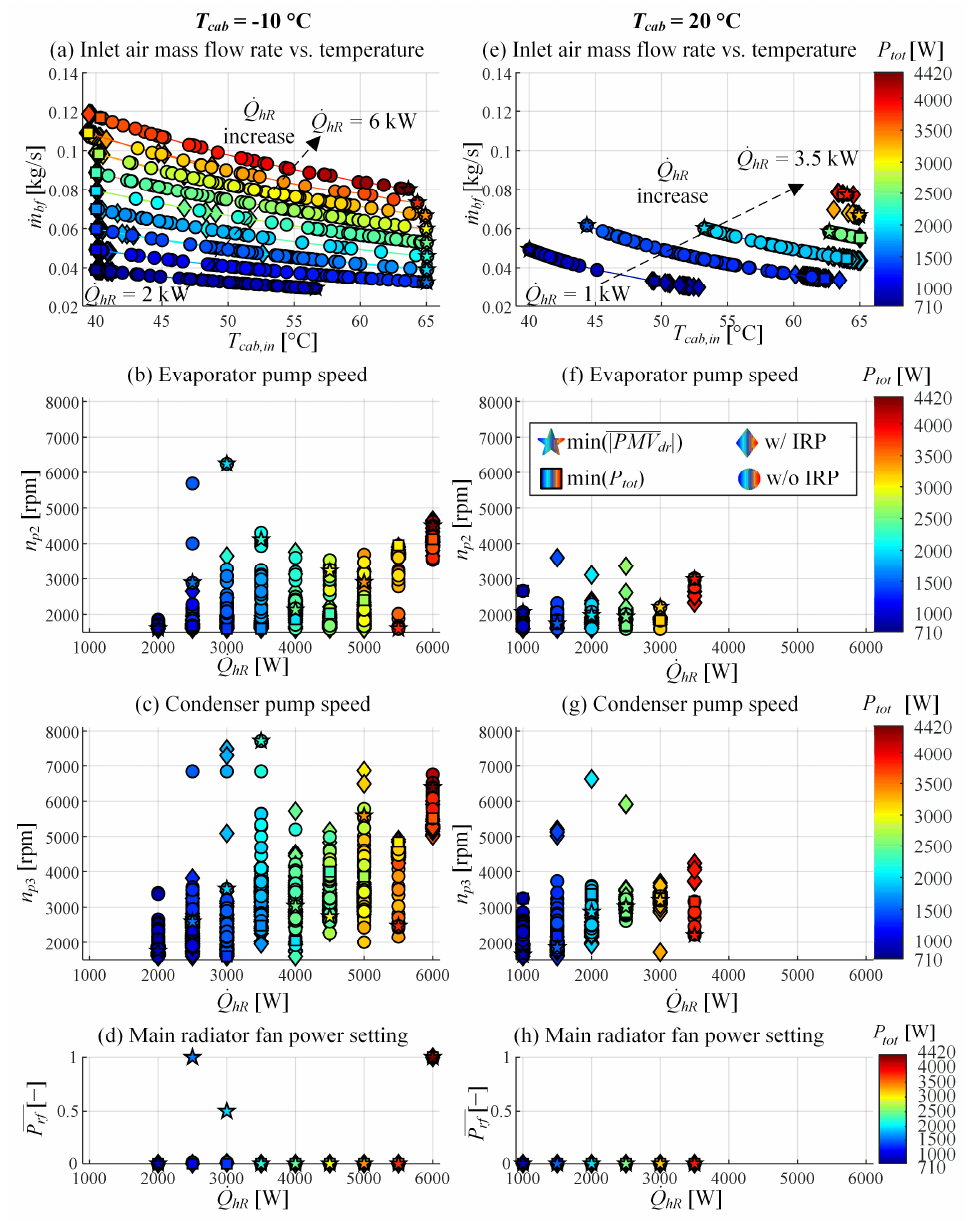
Figure 7. Optimised control inputs corresponding to Pareto frontiers from Figure 5a ( a – d , T cab = − 10 °C) and Figure 5e ( e – h , T cab = 20 °C).